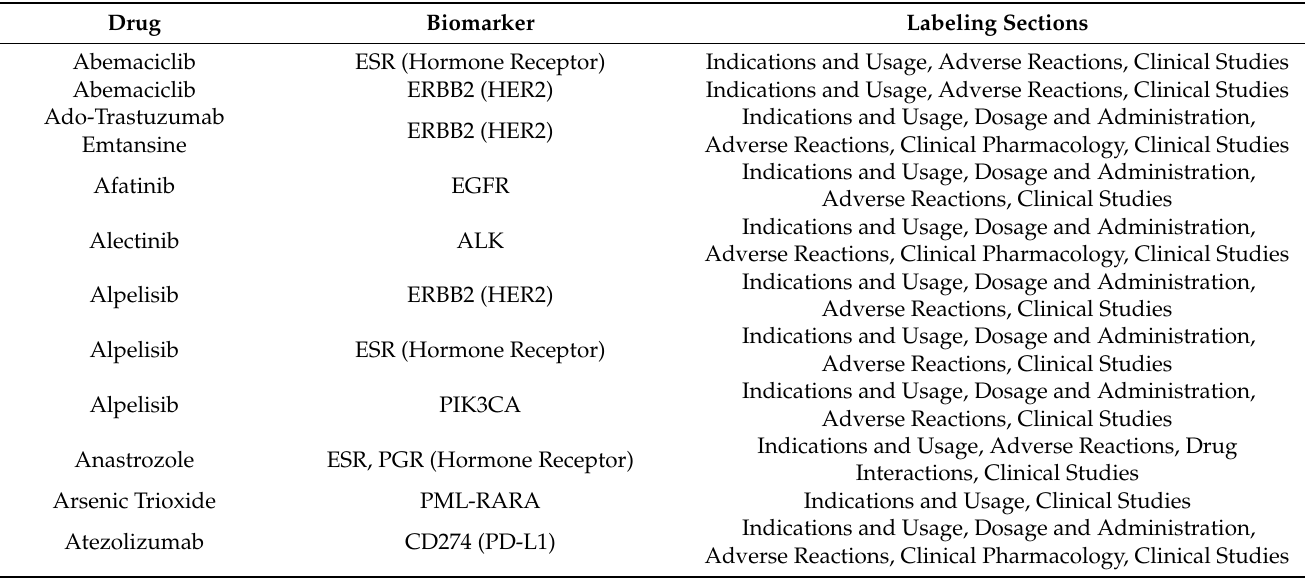
Table 1. Pharmacogenomic oncology biomarkers in drug